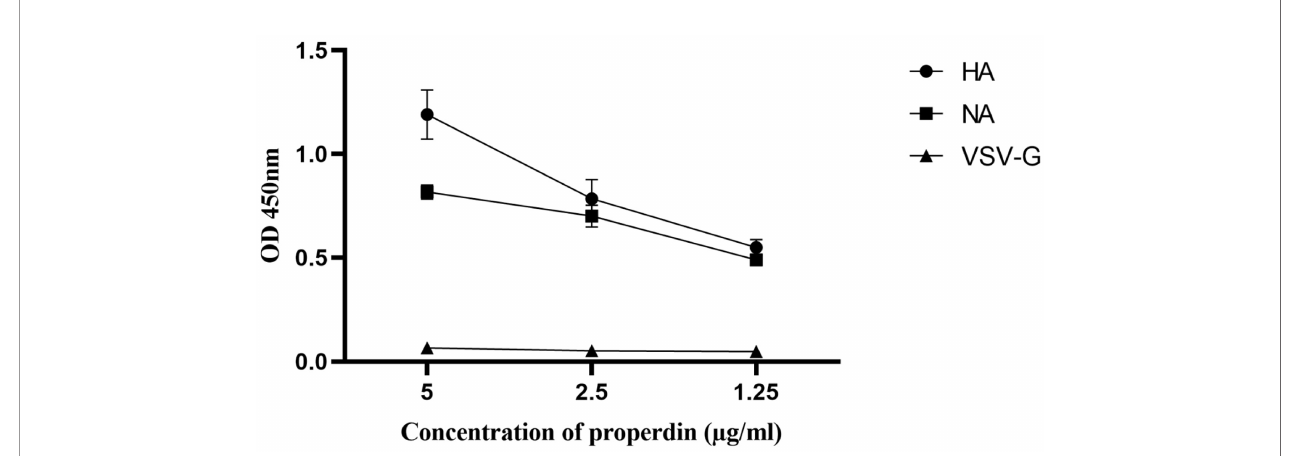
FIGURE 4 | Direct ELISA to show the ability of properdin to bind puri fi ed recombinant hemagglutinin (HA) and neuraminidase (NA) of H1N1. Microtiter wells were coated with varying concentrations of properdin (5, 2.5, and 1.25 m g/ml). 2 µg/well of recombinant HA or NA was diluted in 200 m l of PBS and was added to all the wells. After washes with PBS, the binding was probed with either monoclonal anti-in fl uenza virus H1, monoclonal anti-in fl uenza A virus neuraminidase or polyclonal anti-VSV-G antibody. VSVG was used as a negative control protein, where no signi fi cant binding was detected. The data were expressed as the mean of three independent experiments carried out in triplicates ±